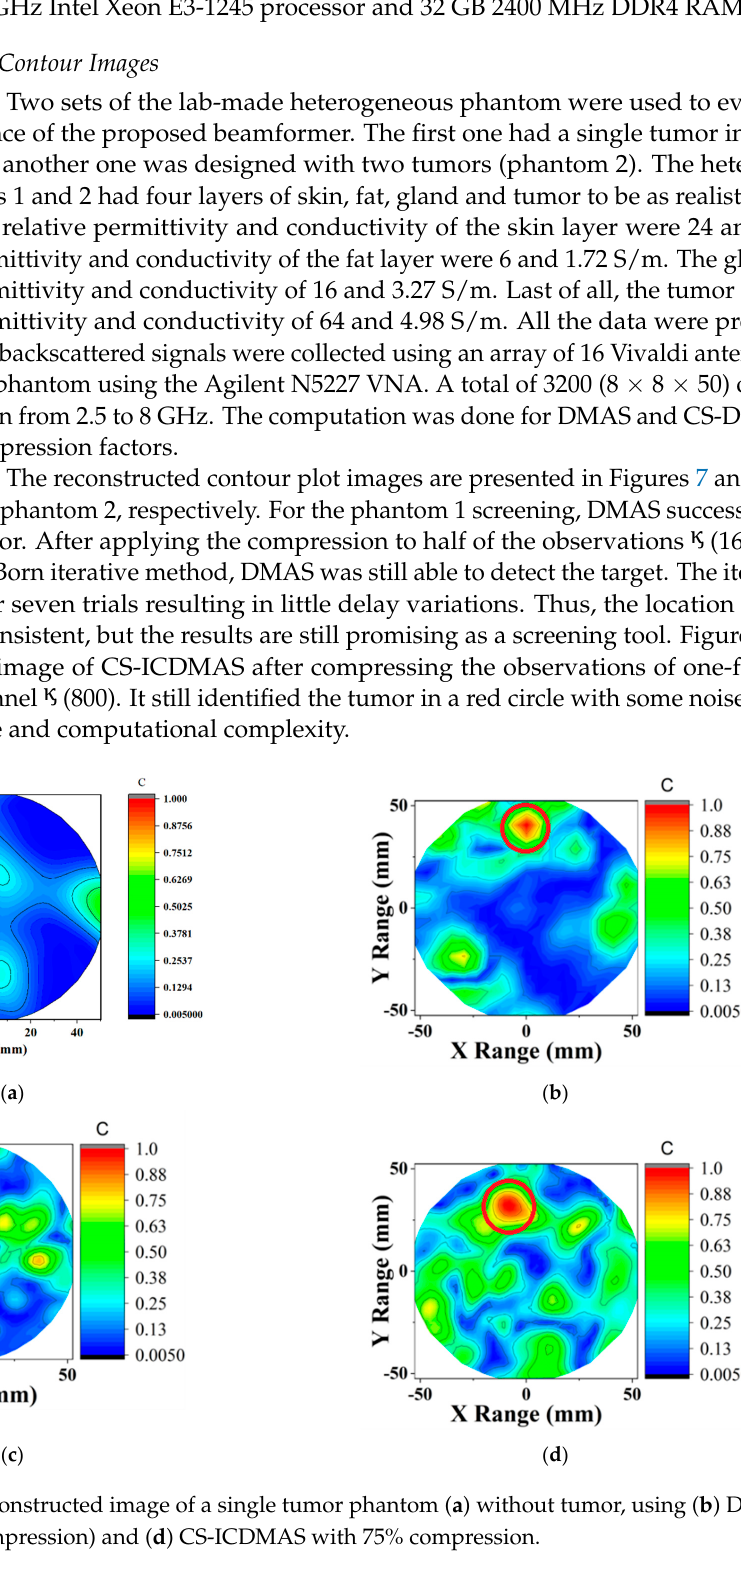
Figure 6. The 8 × 8 scattering matrix measured in the presence of a breast phantom. 3.2. Compressed Sensing in DMAS Three-dimensional Cartesian coordinates of all points inside the region of interest were represented in the i by 3 matrices, C , where i = 1,2,…, and I is the total number of points. Then, the I was generated from C by the I matrix, P C-C , containing the Euclidian